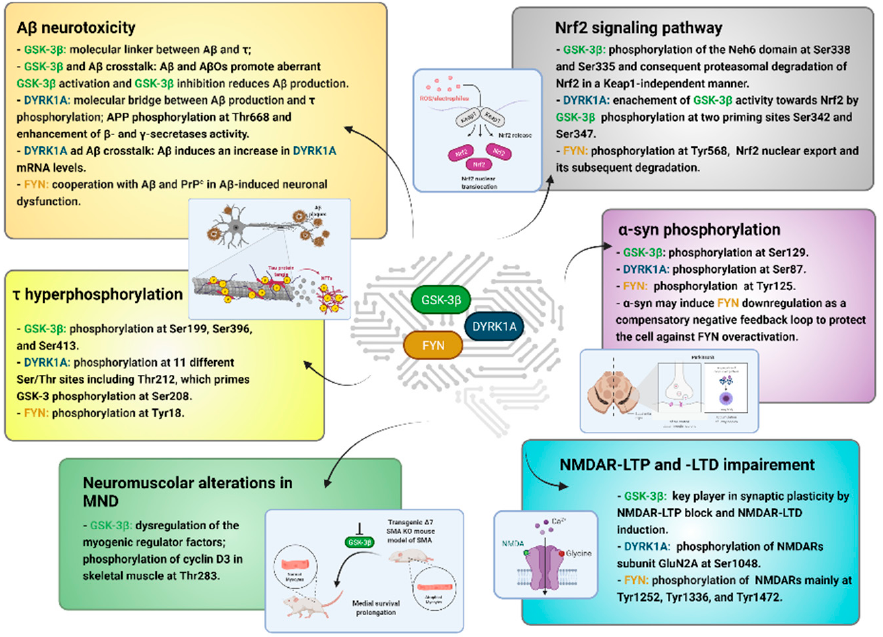
Figure 6. Schematic representation of the general involvement of GSK-3 β , FYN, and DYRK1A in neurodegenerative diseases and motor neuron disease (MND) (created with BioRender.com). Phosphorylation at Thr212 primes τ for phosphorylation by GSK-3 β at Ser208 in vitro, suggesting a more general role for DYRK1A in priming phosphorylation of GSK-3 β sub- strates [32]. Additionally, DYRK1A, by phosphorylation of the alternative splicing factor (ASF) at Ser227, Ser234, and Ser238, causes dysregulation of alternative splicing of τ ,